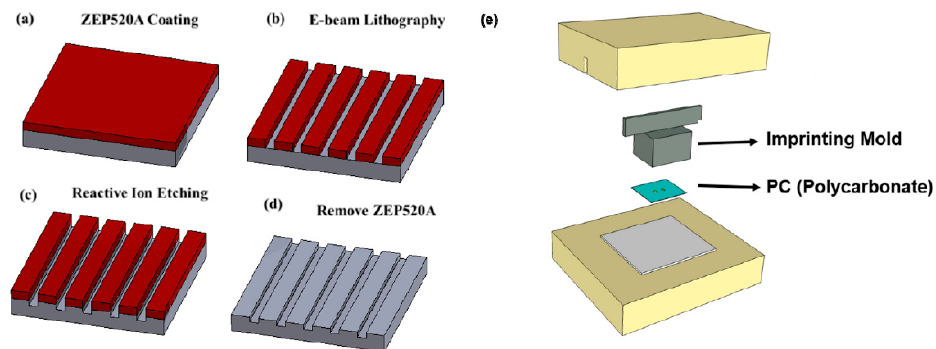
Figure 2. Fabrication of the mold for nanoimprinting. ( a ) spinning coating photoresist, ( b ) e-beam lithography to pattern photoresist, ( c ) RIE etching the silicon substrate, ( d ) remove photoresist and ( e ) use the silicon substrate as the mold to hot emboss PC substrate.